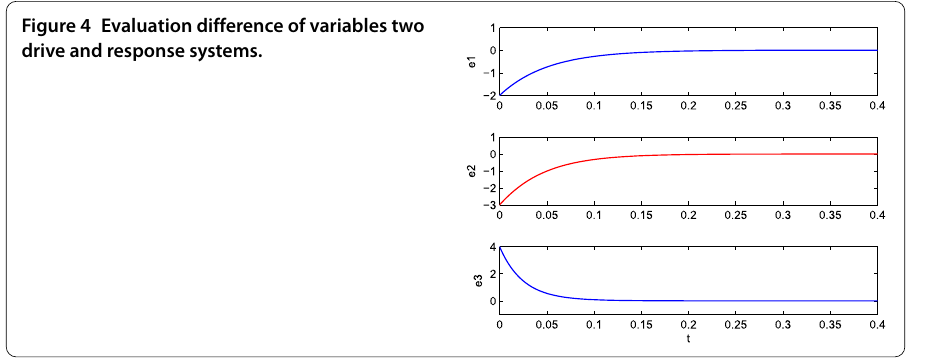
Figure 4 Evaluation difference of variables two drive and response